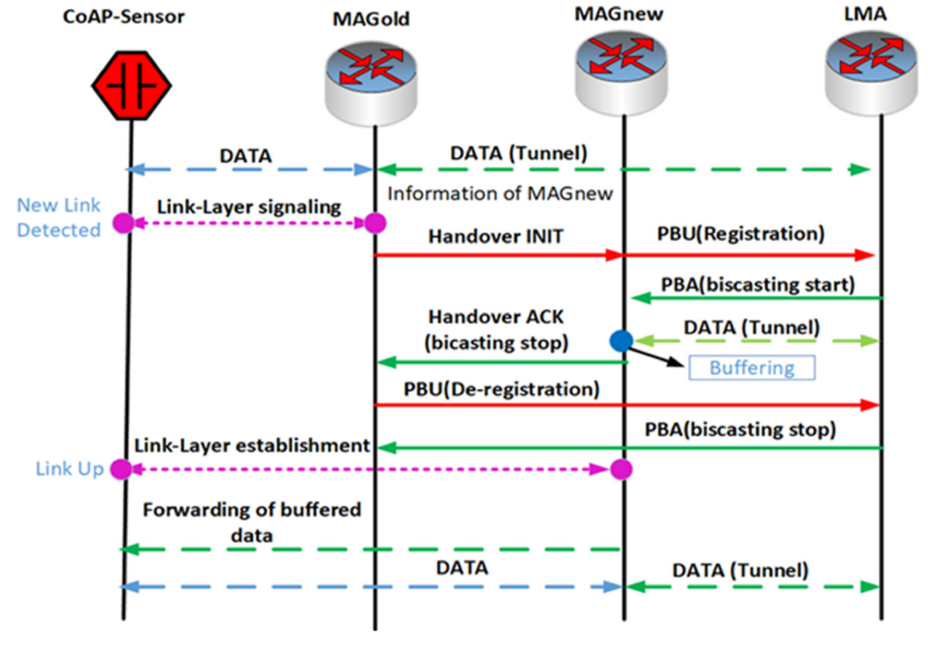
Figure 2. Partial Bicasting for PMIP (PB-PMIP) for internet of things (IoT).